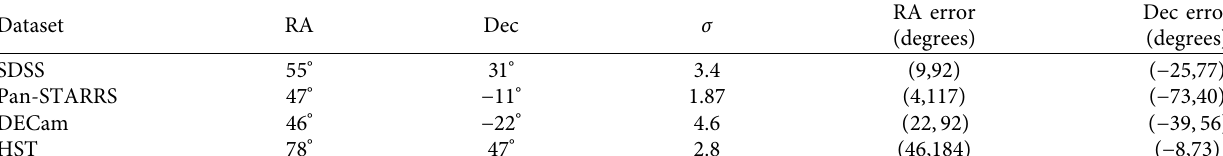
Table 9: Most likely dipole axes from the data from the four digital sky surveys.